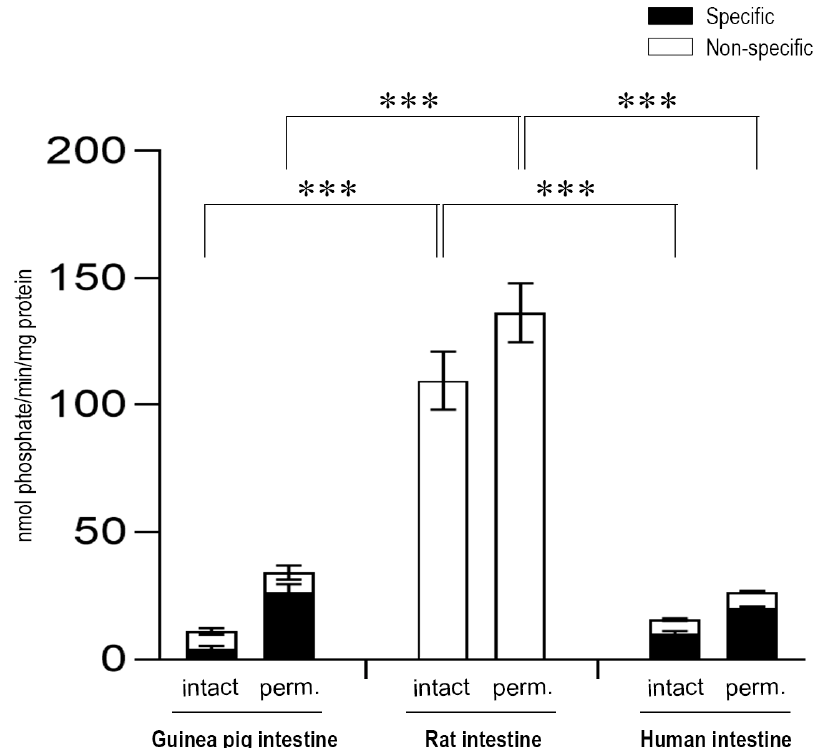
Figure 5. Mannose-6-phosphate hydrolyses in the intestine with the mannose-6-phosphate substrate by measuring phosphate production. All samples were washed three times and incubated at 37 °C in the presence of 10 mM of the mannose-6-phosphate substrate for 10 min. All experiments were performed in triplicate and repeated three times; n = 3 for all species. Bars display mean ± SEM, and statistical analysis was performed using a one-way ANOVA with a Tukey post hoc test with p ≤ 0.001 ***. M6P = Mannose-6-phosphate. Activity measurements were performed by the specific inactivation of G6Pase with a brief exposure of the samples to pH 5.0. Specific G6Pase activity was calculated as the difference between untreated and pH 5.0 treated samples.